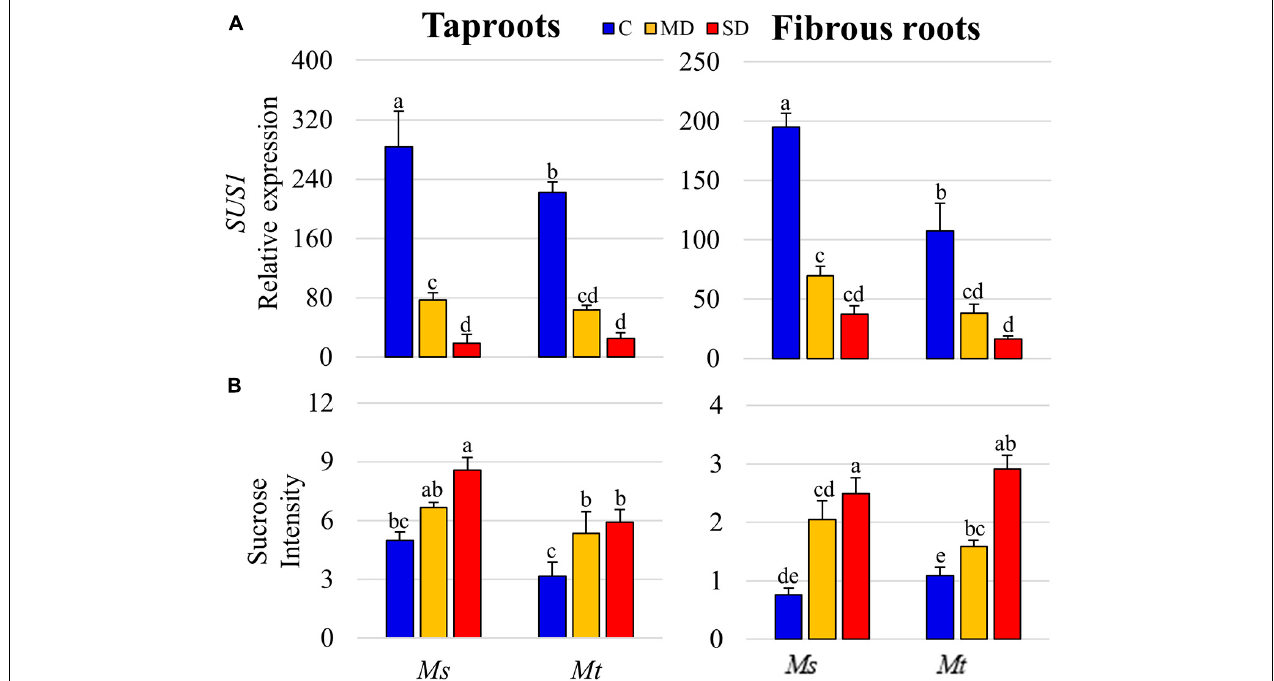
FIGURE 7 | Sucrose synthase 1 ( SUS1 ) gene expression and sucrose levels. (A) ( SUS1 , gene ID Medtr4g124660) relative gene expression and (B) sucrose relative levels in roots of plants subjected to water deficit. Values represent means ± SEs ( n = 4 biological replicates). Different letters indicate significant differences according to a Duncan-test ( P ≤ 0.05). C, control; MD, moderate water deficit; SD, severe water deficit; fibRs, fibrous roots; tapRs, taproots; Medicago. sativa, Ms; M. truncatula, Mt